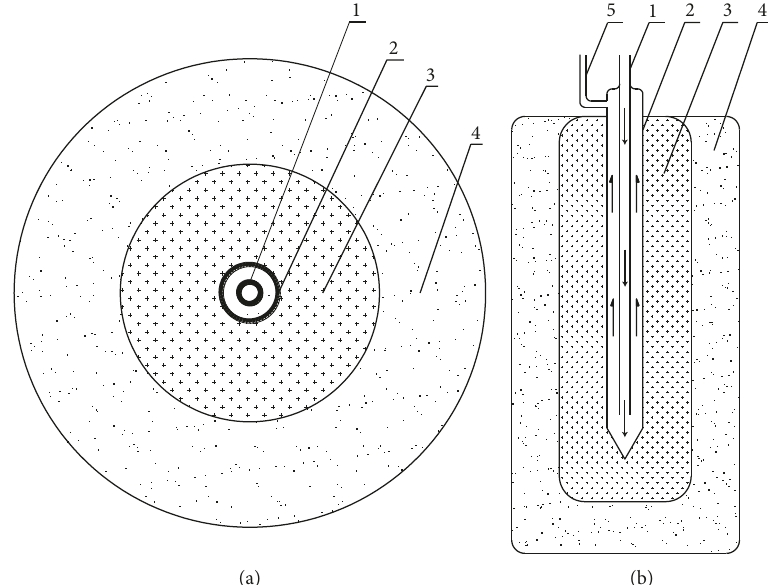
Figure 17: Schematic diagram of the thermal pile (1: liquid pipe; 2: heating pipe; 3: brick pile; 4: drying section; 5: liquid suction pipe); (a) plan view; (b) elevation view.